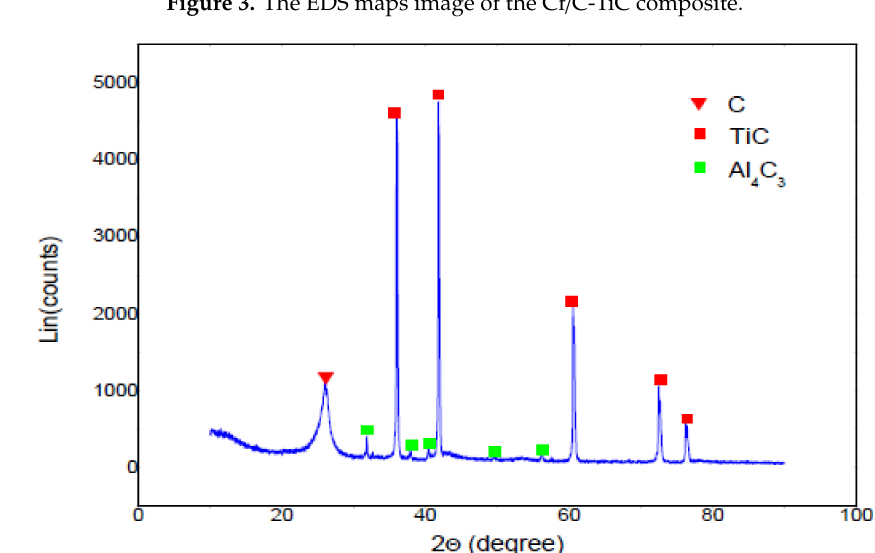
Figure 4. XRD patterns of the Cf / C-TiC